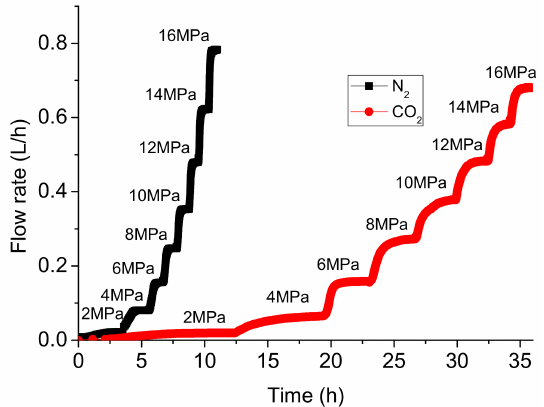
Figure 3. Development of downstream flow rates with time under steady-state conditions at confining pressure of 40